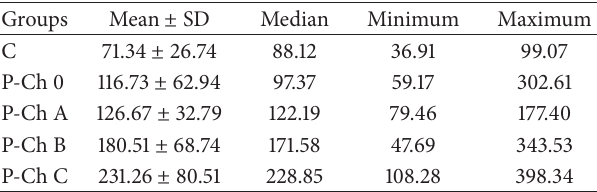
Table 3: HGF concentration (pg/mL) in the serum of alcoholics and healthy controls.